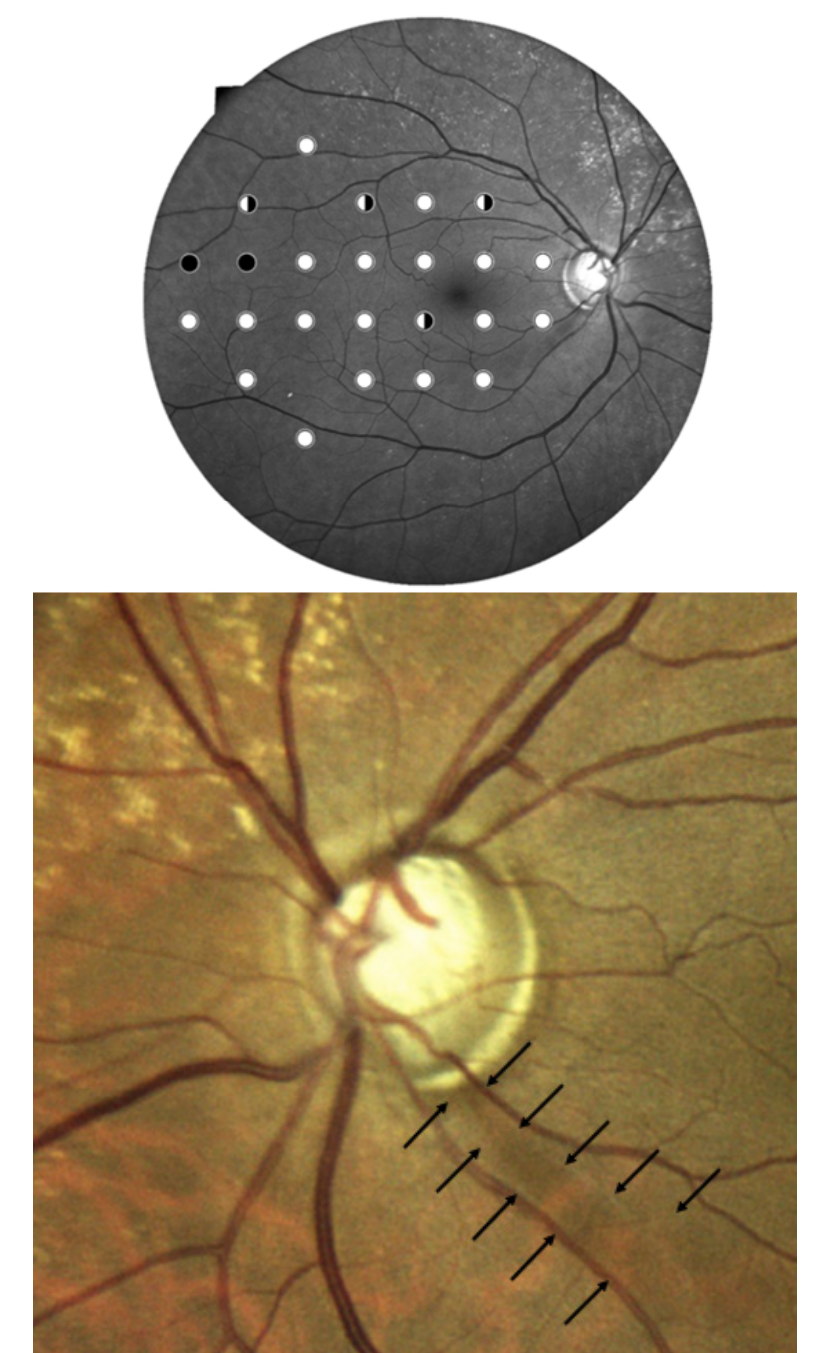
Figure 2. This is the case of a 60-year-old woman with bilateral glaucoma. Standard perimetry showed a bilateral damage (( a ) Right eye, superior relative diffuse defect; ( b ) Left eye, relative superior nasal step and relative inferior arcuate defect). ( c ) OCT showed focal RNFL thinning corresponding to the visual field damage in both eyes. ( d ) The patient received SST in the right eye, and defects at both hemifields were correctly identified; the test was deemed as abnormal (STR = 2%), in agreement with the clinical judgement. ( e ) In the left eye, the patient underwent QST. The screening procedure was able to detect the damage in the superior hemifield shown with standard perimetry; in the inferior hemifield, just an abnormal nasal location was correctly identified, whereas the peripheral abnormal locations of the standard perimetry were undetected. The judgement by STR was borderline (8%). Interestingly, the presence of ONH imaging would strongly allow direct integration of functional and morphological data. ( f ) Inspecting the glaucomatous optic nerve head with RNFL defects (arrows), an ophthalmologist would easily perform a correct assessment of glaucoma.